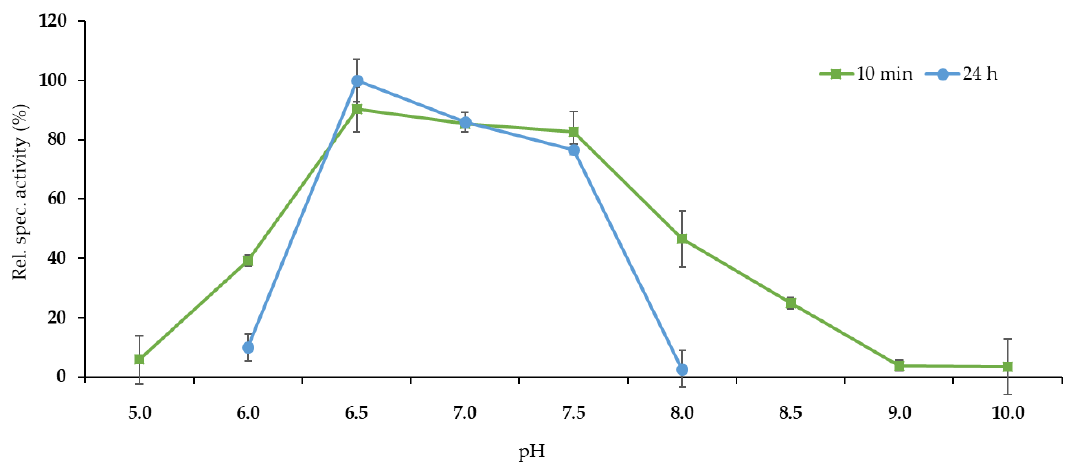
Figure 2. pH profile of Ppo-Er1 measured between pH 5 and pH 10 in Davies buffer [44]. The enzyme was preincubated at 25 °C in the respective measurement buffer solution for 10 min and 24 h, respectively, to determine the stability and activity of Ppo-Er1 in dependence of pH. Relative specific activity corresponds 100% to an activity of 0.41 U/mg for cyclohexenone. The error bars show the standard deviation of triplicates.